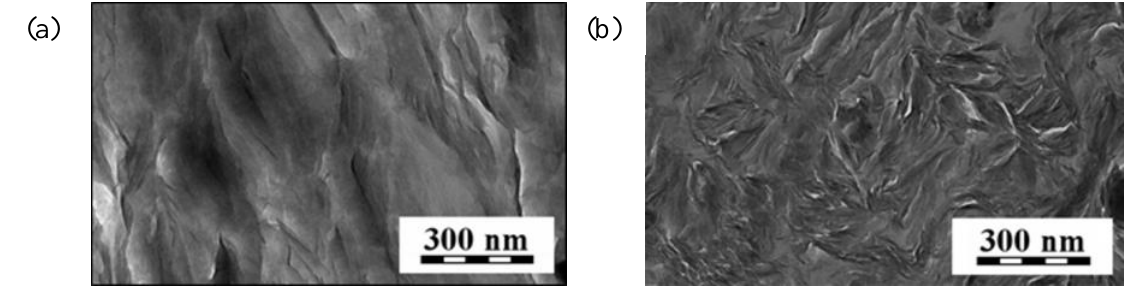
Figure 15. TEM microphotographs of ultra-microtome cuttings of nanocomposites: EPBP1IHSP3-3.0 ( a ), EPBP1IHSP3-4.5 ( b ).